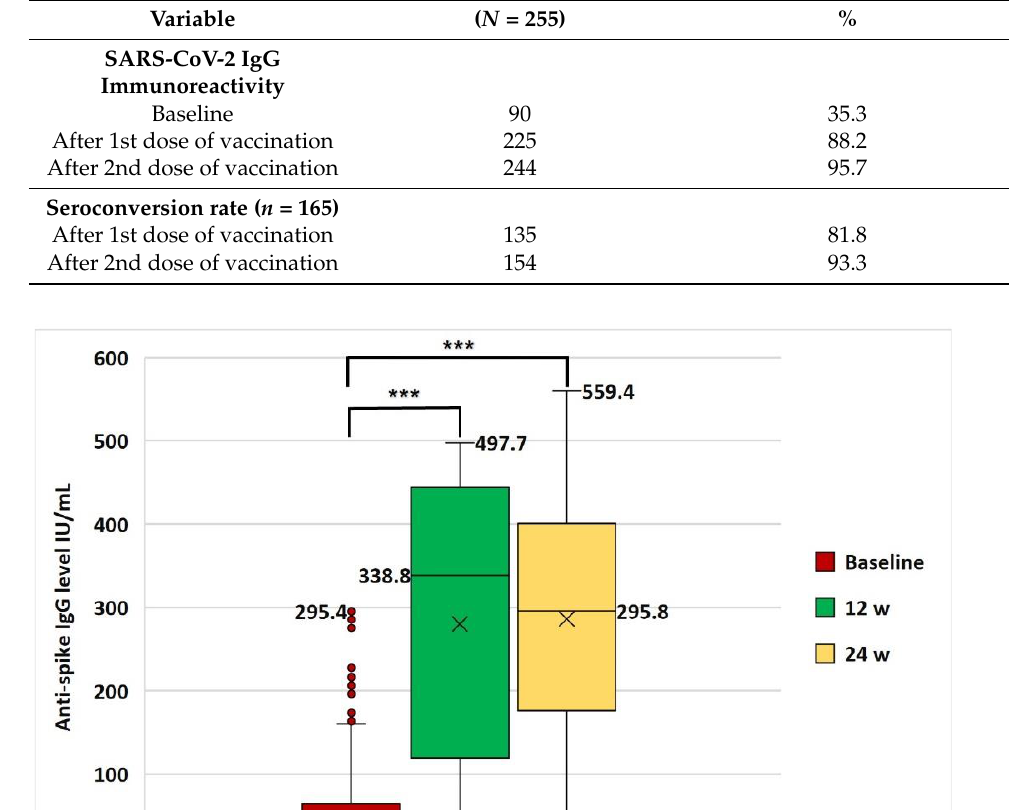
Table 3. Immunoreactivity and seroconversion rate at different time points of the study.